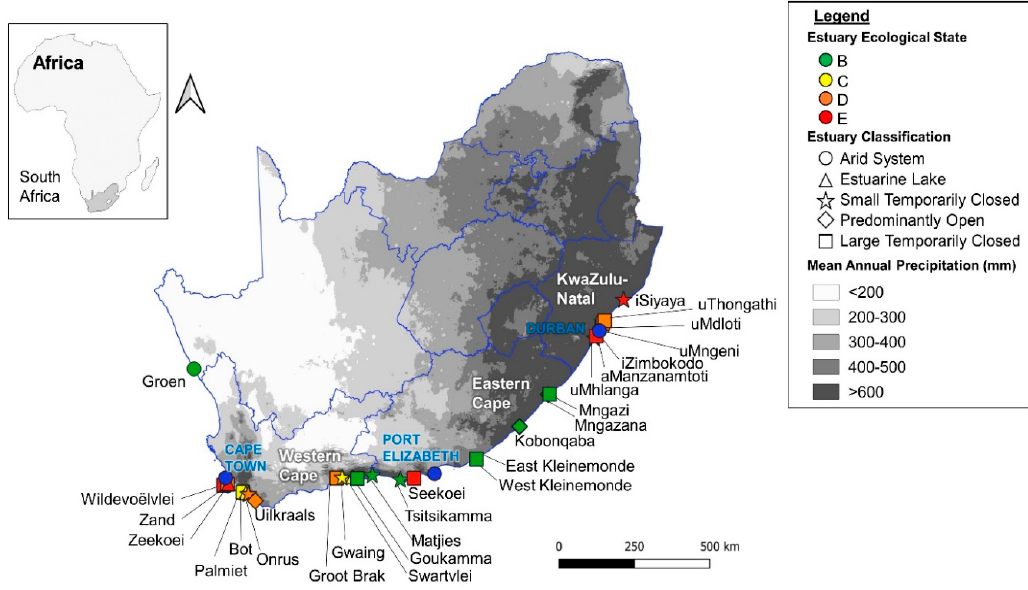
Figure 3. The South African coastline indicating estuaries mentioned in the text.